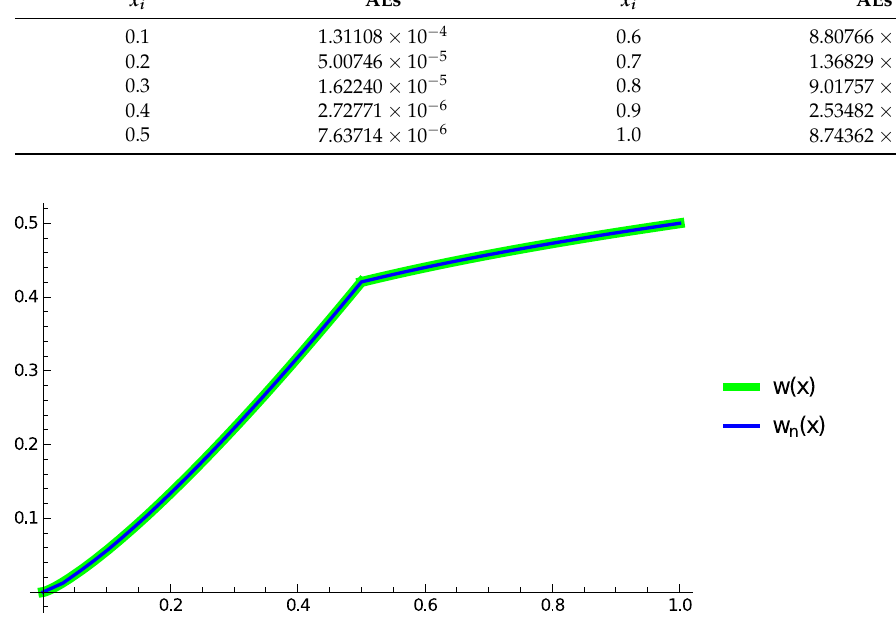
Figure 1. The ε -approximate solution w n ( x ) and the exact solution w ( x ) of Example